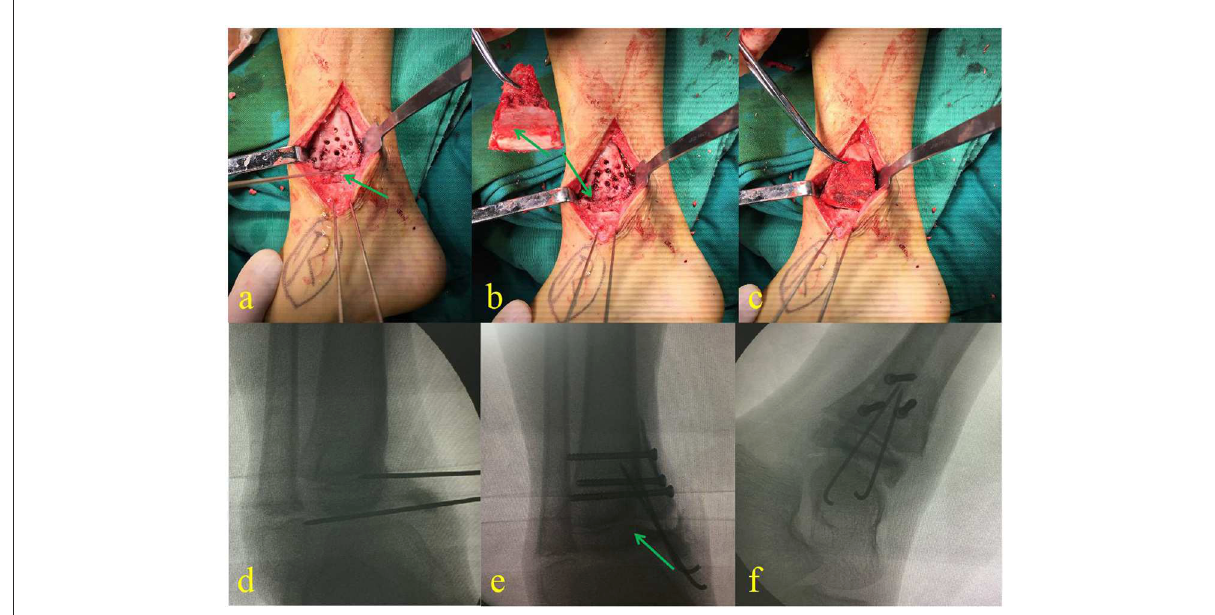
FIGURE3 Debridement and location of the distal tibial physis with a K-wire (a) . Harvested iliac crest apophyseal autograft, ready to insert in an appropriate place (b) . The cartilage of the iliac crest autograft was positioned to meet the medial aspect of the talus (c) . (d–f) Are the fluoroscopic images taken during the surgery.